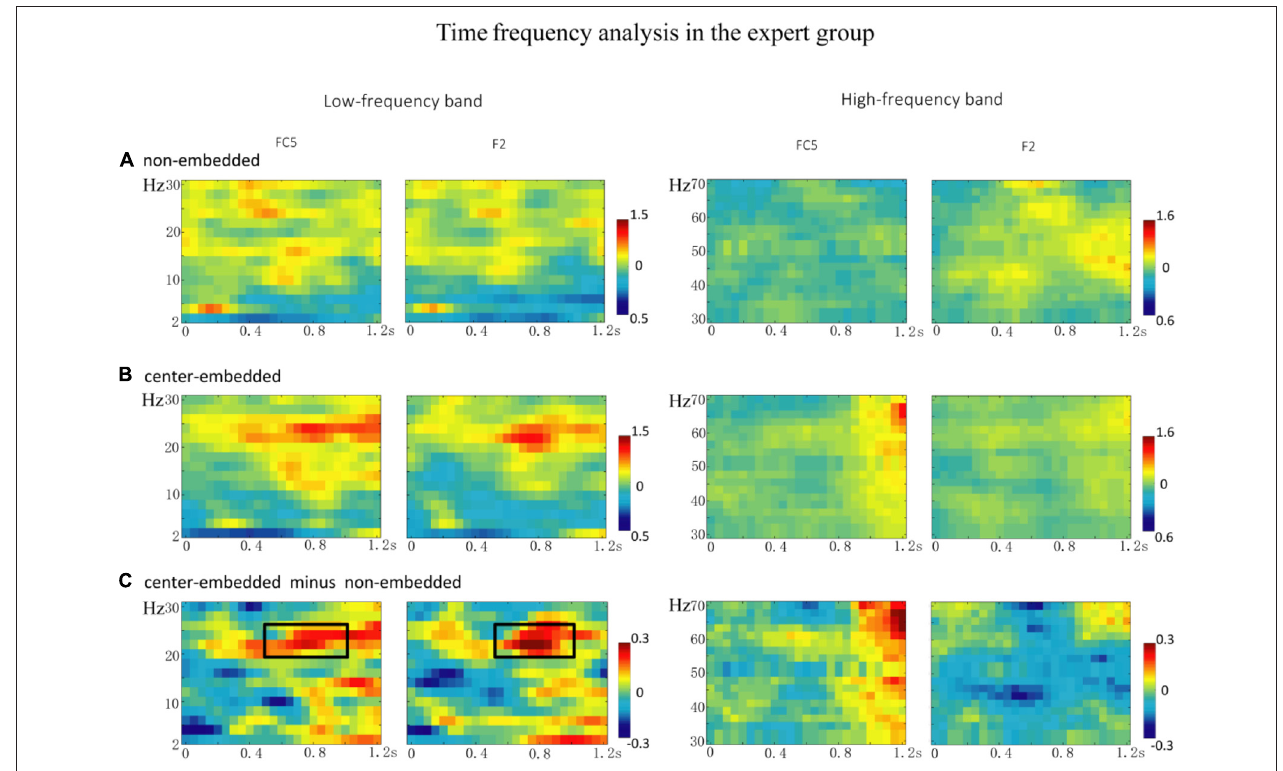
FIGURE 6 | The time frequency analysis of final chords in the expert group. (A,B) Time frequency representations of the non-embedded and center-embedded conditions at electrodes FC5 and F2, for the low and high frequency ranges. (C) The contrasts of the center-embedded and non-embedded conditions at the same electrodes. The black boxes indicate the frequency-band (20–26 Hz) within the selected time window (500–1,000 ms), indicating a significant difference between the two